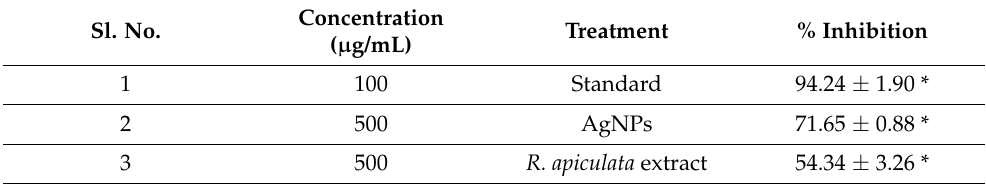
Table 6. Anti-inflammatory activity of aqueous leaf extract of R. apiculata and its synthesized AgNPs. Sl. No.